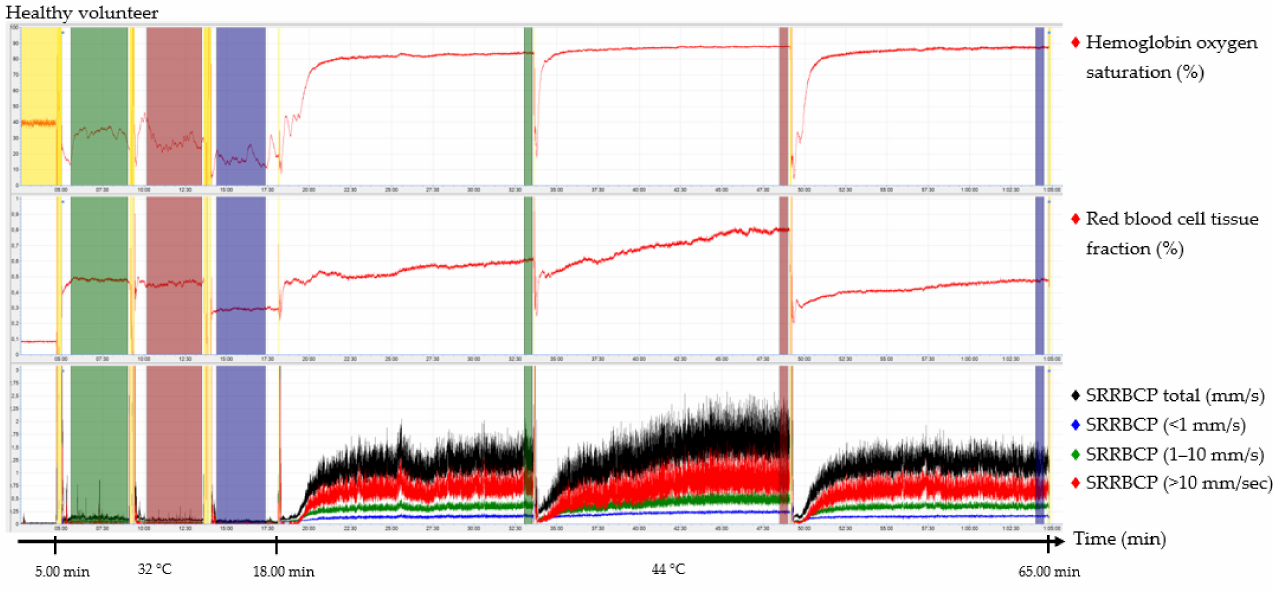
Figure 2. Continuous enhanced perfusion and oxygen saturation (EPOS) values of one healthy volunteer. Green times of interest (TOIs) are measurements on the dorsal side of the foot. Red TOIs are measurements on the medial side of the foot. Blue TOIs are measurements on the calf. Yellow regions are motion artifacts. All participants rested at least 5 min before recordings started. SRRBCP: speed-resolved red blood cell